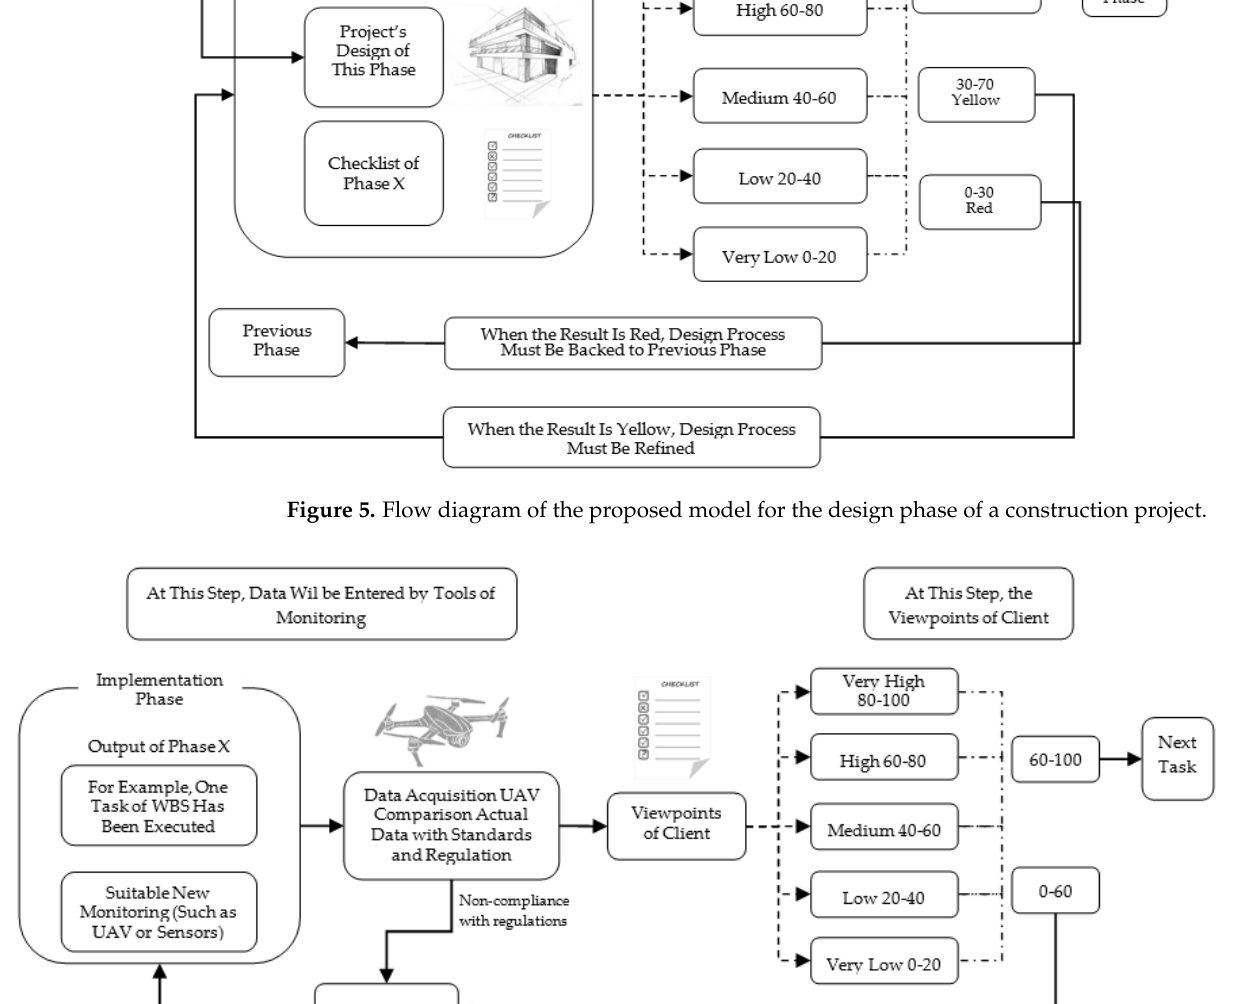
Figure 5. Flow diagram of the proposed model for the design phase of a construction project.